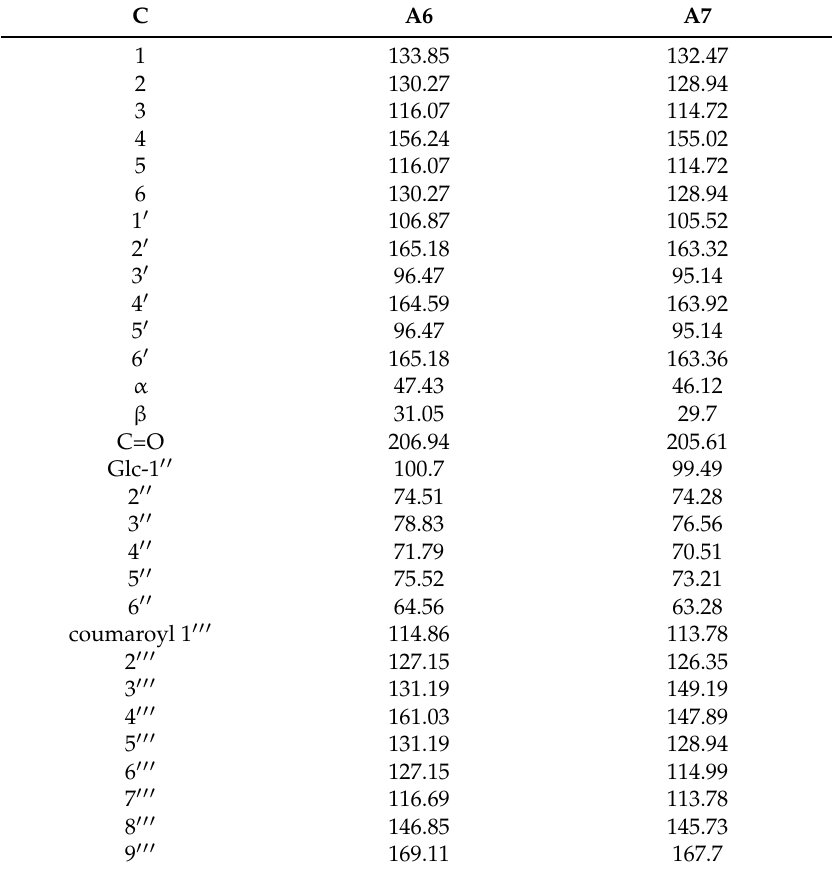
Table 2. 13 C-NMR Data (125 MHz) of compounds A6 and A7 in CD 3